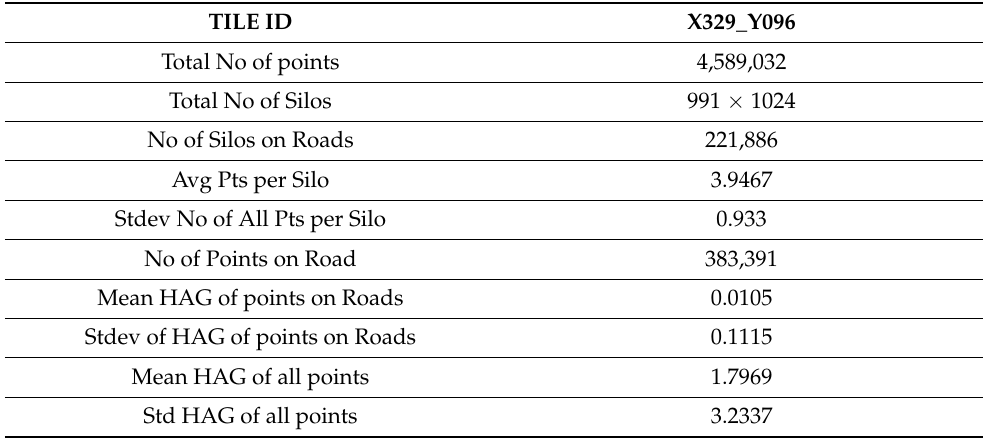
Figure 7. ( a ) LiDAR HAG data after filtering and ( b ) Roads identified. Table 1. Case 1 Results